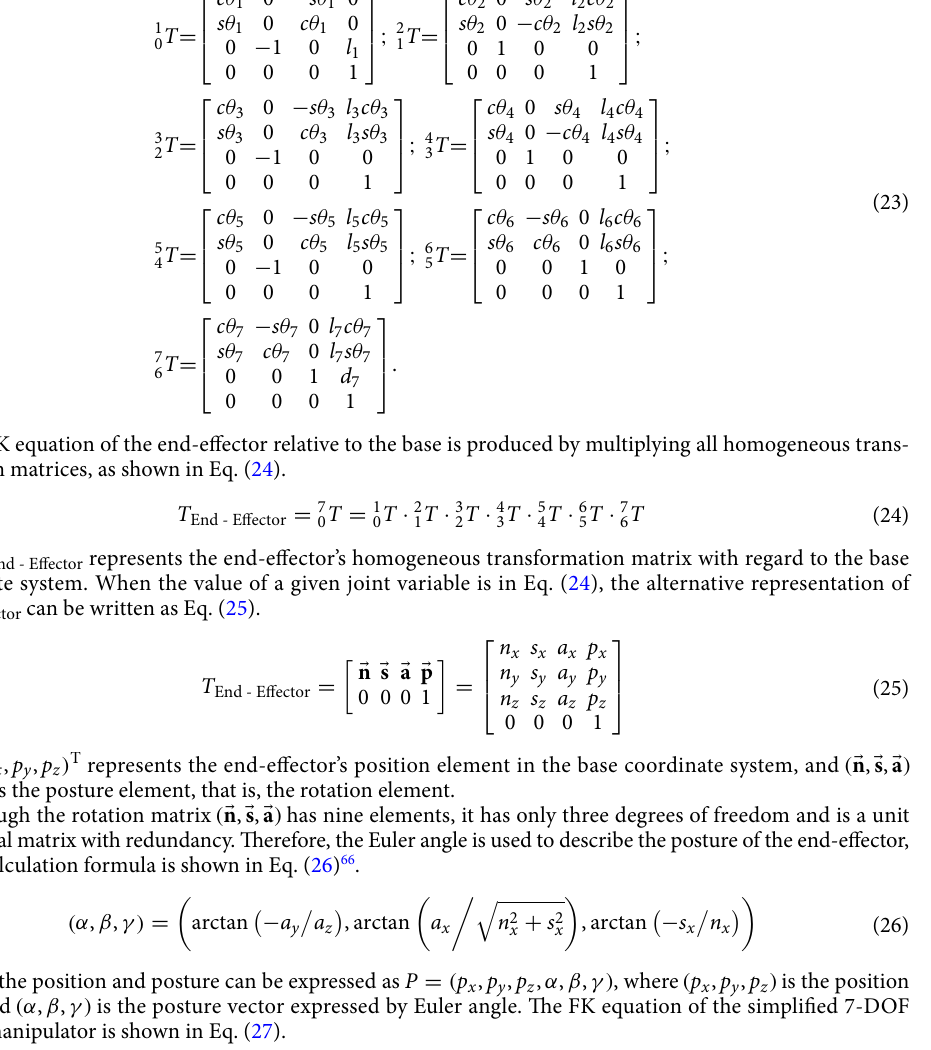
Thus, the position and posture can be expressed as P = ( p x , p y , p z , α , β , γ) , where ( p x , p y , p z ) is the position vector and (α , β , γ) is the posture vector expressed by Euler angle. The FK equation of the simplified 7-DOF robotic manipulator is shown in Eq. (27).